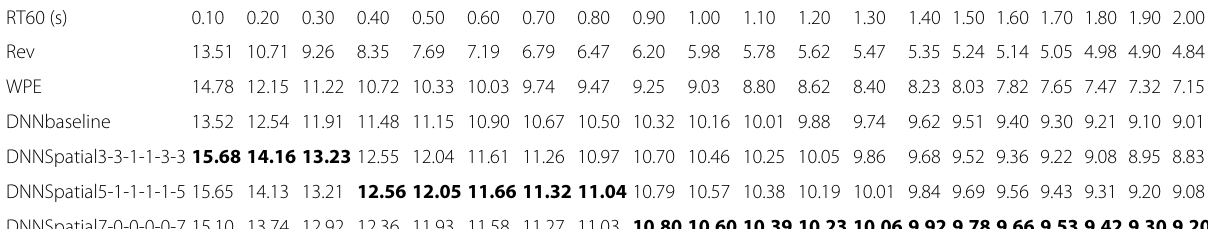
Table 1 Average 6-microphone fwSegSNR of different DNNSpatial configurations at different RT60s